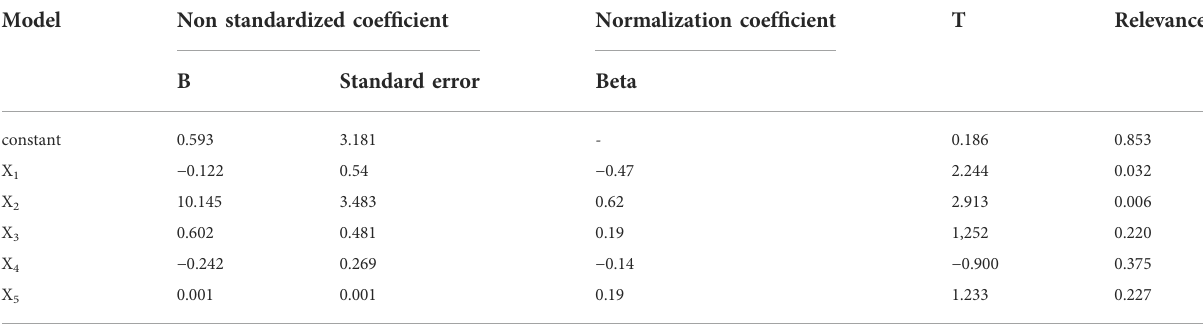
TABLE 2 Table of regression coef fi cients of various factors (the gas-liquid two-phase fl ow stage).